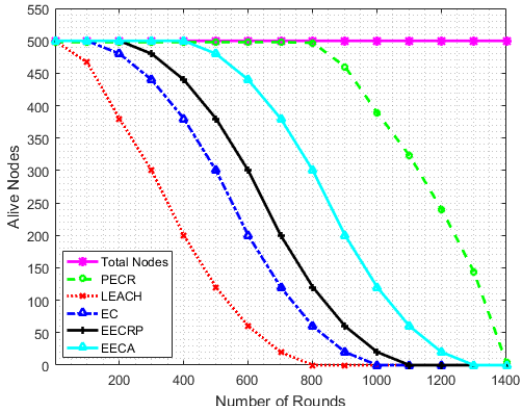
Figure 6. The overall sum of alive nodes.